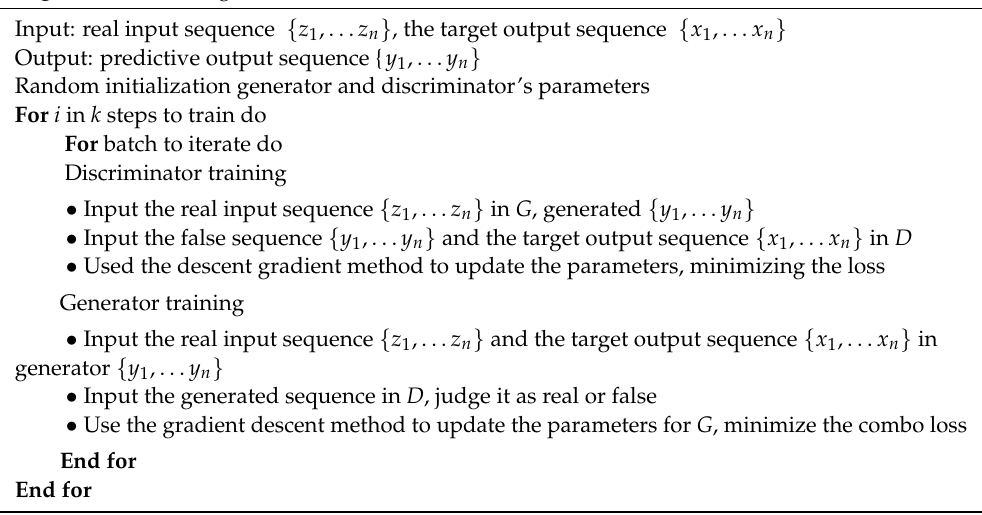
Algorithm 1: The Algorithm of Transformer and GANs